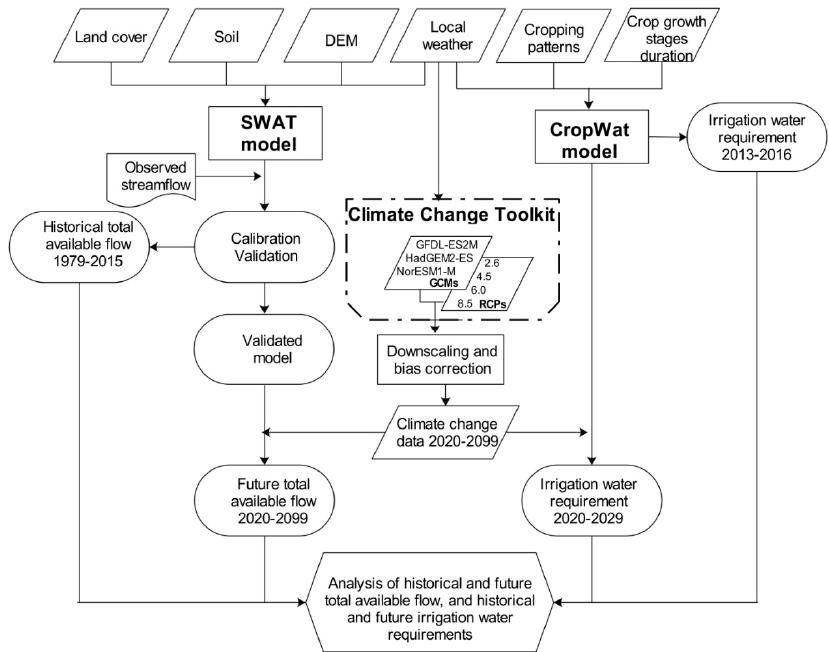
Figure 1. Overview of the methodological approach.